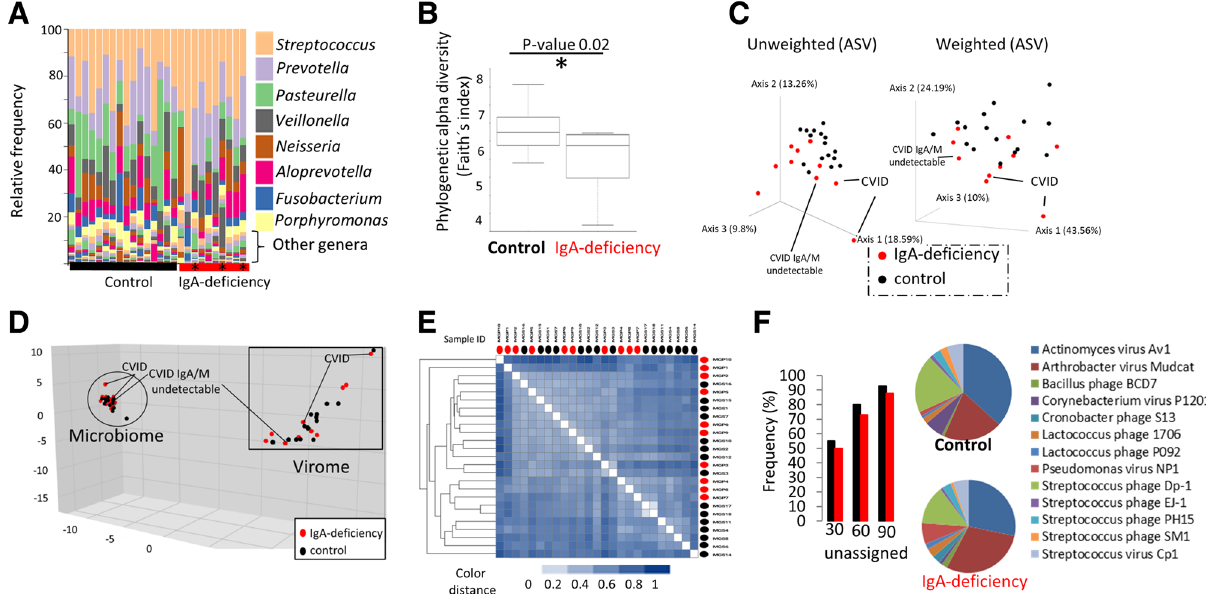
Figure 1. Diversity, composition and metabolic functionality of human oral microbiome and virome from control and IgA deficiency. ( A ) Taxonomic analysis at the genus level based on 16S rRNA gene Illumina amplicon sequencing. Relative abundance (%) of the most abundant genera (at least > 1% of abundance) is displayed. For convenience, these other rare taxa are not depicted in panel enumerating species. Star denotes CVID patients. ( B ) Comparison of phylogenetic alpha richness diversity by Faith’s index between groups. Other alpha diversity indices used in Qiime program were not conclusive (p-value > 0.05). ANCOM test implemented in Qiime2 did not found statistical differences for common abundant bacterial commensalists. ( C ) PCoA representing Unweighted and Weighted Unifrac distance for controls and IgA-deficiency. Three samples were from CVID patients. ( D ) PCA representing the analysis and comparison of more than 300,000 annotated genes from each group (control and IgA-deficiency samples) recovered by metagenomics and viral metagenomics. Genes were annotated by COG at the IMG-JGI bioinformatic platform. Similar representation was obtained for pfam and other gene annotation methods. ( E ) Massive Metagenomic analysis of pairwise comparison of raw reads obtained from control and IgA-deficiency samples. Metafast program was used to compute the analysis. Heat map illustrate relatedness between the pairwise sample comparison. Color distance from 0 (white color) to value 1 (dark blue) indicates the distance. A value of “0” or white color indicates that two samples are identical. ( F ) Metaviromic analysis of assembled viral contigs from viral metagenomes from groups. Viral metagenomes were quality trimmed, assembled, annotated at the IMG-JGI bioinformatic platform, computed the best-hit scoring for each annotated gene using three different thresholds (30, 60 and 90% of amino acid identity). Bar chart represents the fraction of annotated genes with unknown function (named “unassigned”) using the three different identity thresholds. Data indicate that most of the genes were unknown. Results from the taxonomic assignment of viral genes by best-hit scoring are shown in the pie